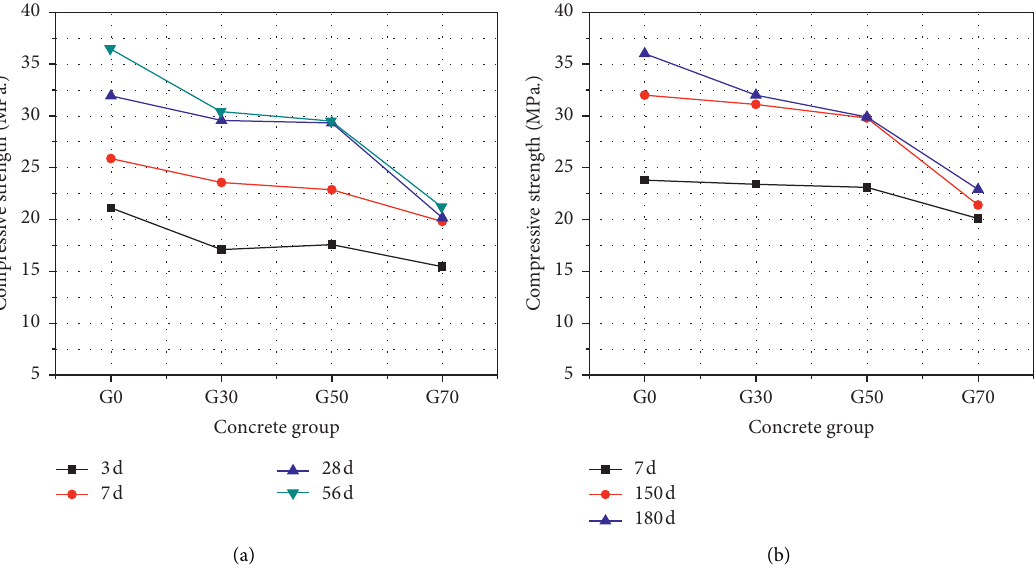
Figure 3: Influence of (a) accelerated carbonation and (b) natural carbonation on compressive strength of concrete with different cement replacement.